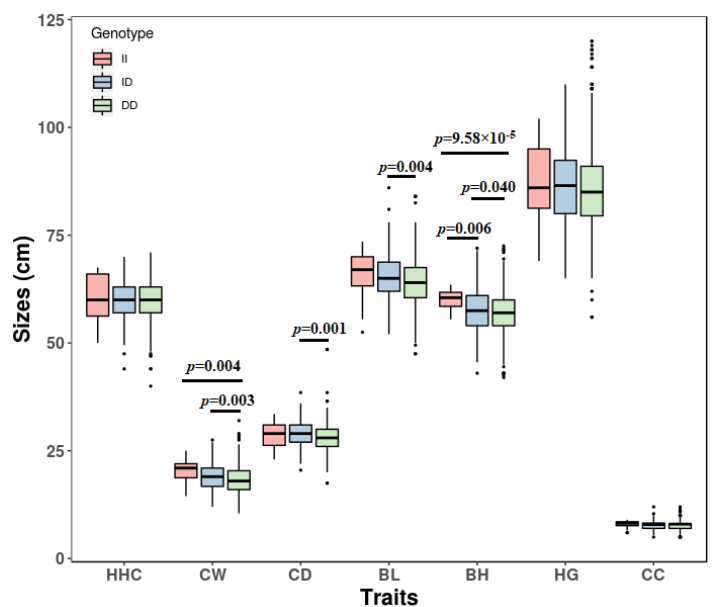
Figure 2. The association of goat SPAG17 14 bp indel and body measurement traits of Shaanbei cashmere goats. The P values were the results of post hoc multiple comparisons between genotypes. II, homozygote insertion genotype; DD, homozygote deletion genotype; ID, heterozygote genotype. HHC, height at hip cross; CW, chest width; CD, chest depth; BL, body length; BH, body height; HG, heart girth; CC, cannon circumference.